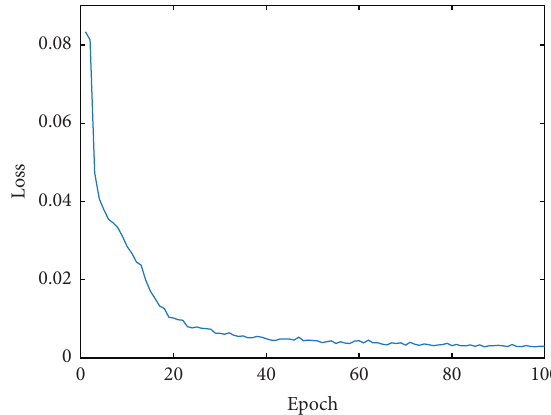
Table 2: Parameters of MS-CNN.